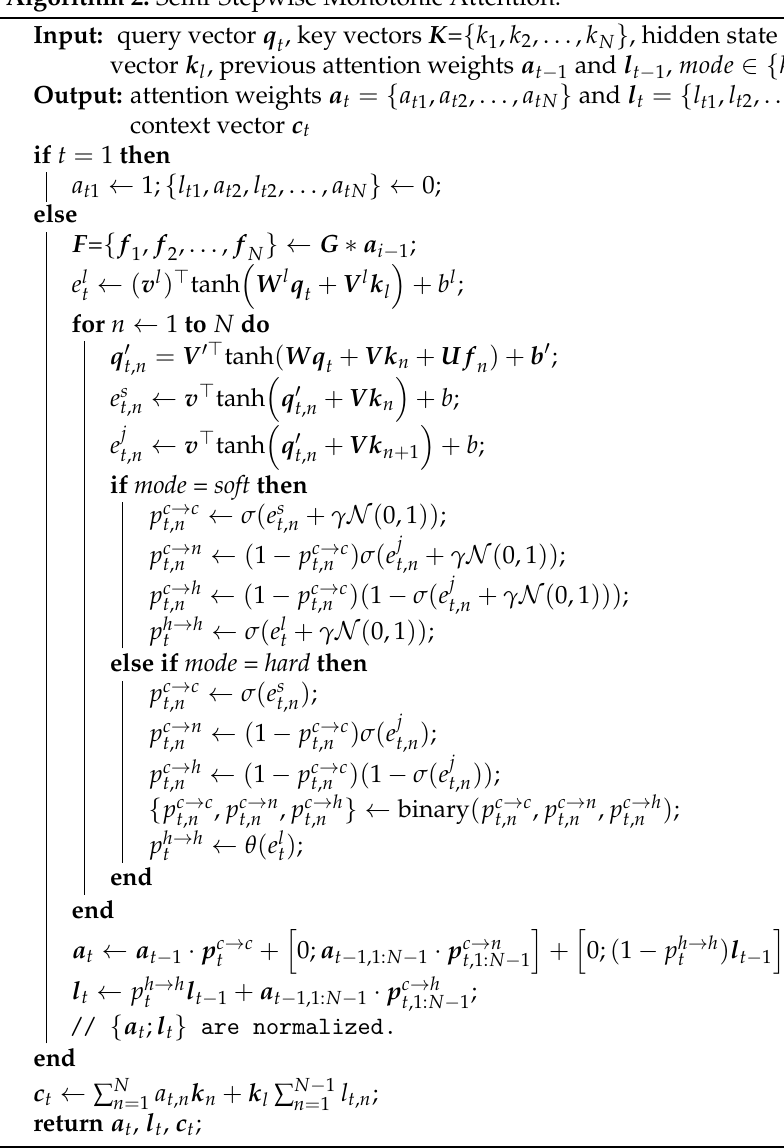
Algorithm 2: Semi-Stepwise Monotonic